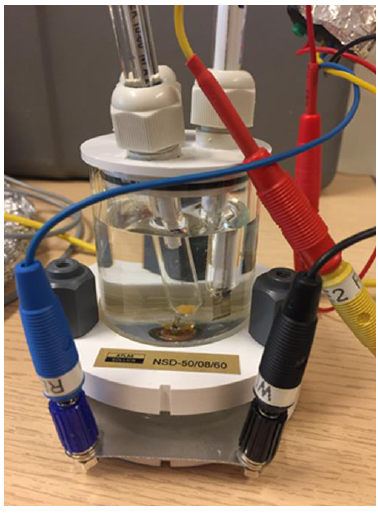
Fig. 1. The measurement site for corrosion tests